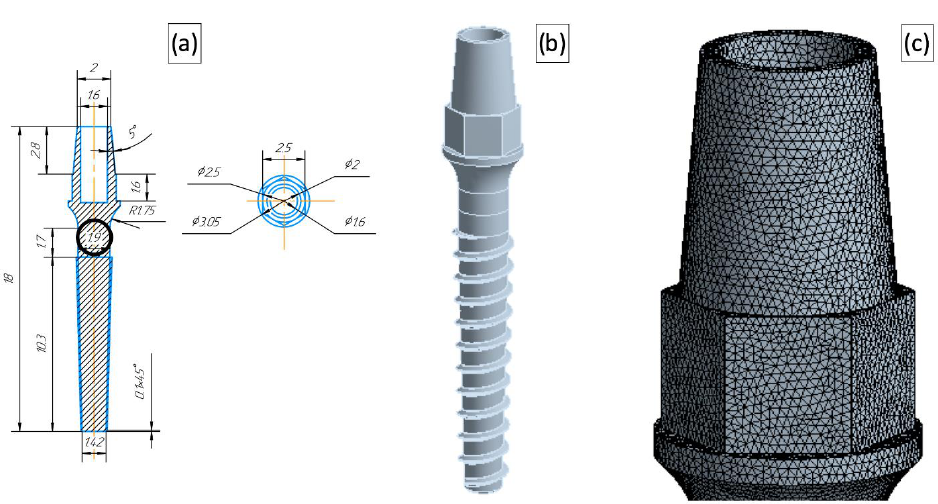
Figure 3. Dental implant model with a reduced diameter (1.9 mm). A technical drawing ( a ) with the diameters used for the model differentiation put into circles, where the dimensions are given in mm; The 3D CAD model ( b ); A magnified view of the FEM mesh ( c ).